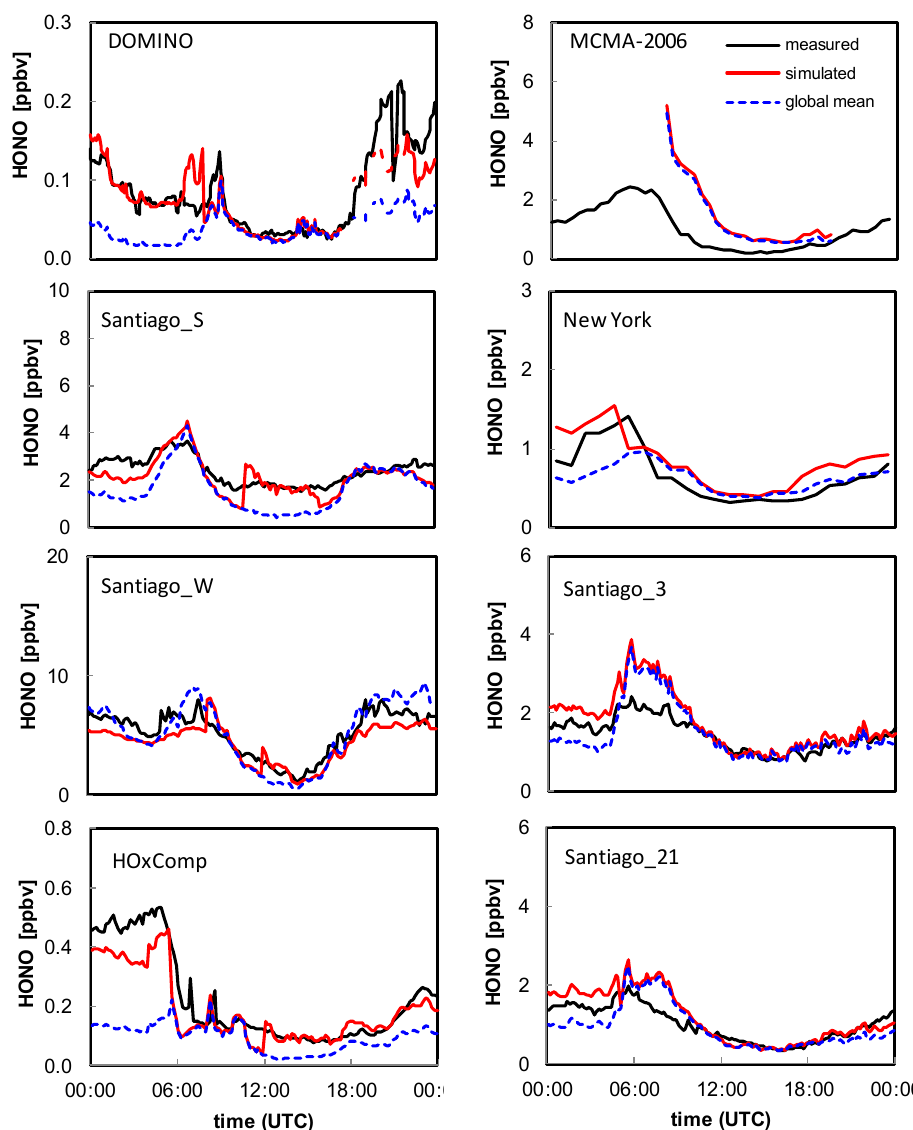
Fig. 5. Simulated diurnal HONO cycles based on the Eq. (1) to Eq. (6) for the different sectors (simulated) and those based on the mean HONO/NO x ratio of 0.02 (global mean), compared to measurements in different campaigns. Small spikes appear between sectors due to the different parameterizations applied.